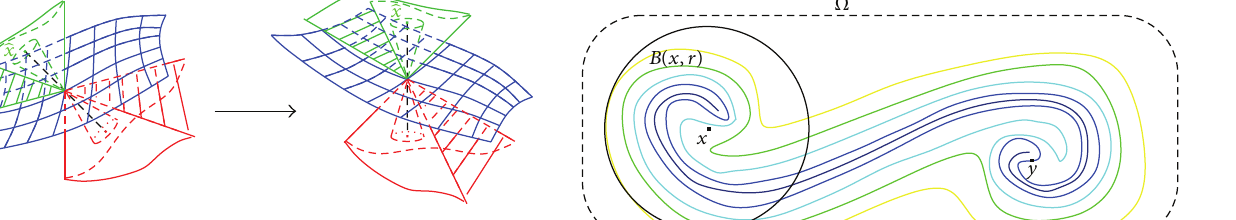
Figure 7: Rotating the graph of 𝑓 so that the line segment from 𝑦 to ̂𝑥 becomes vertical.